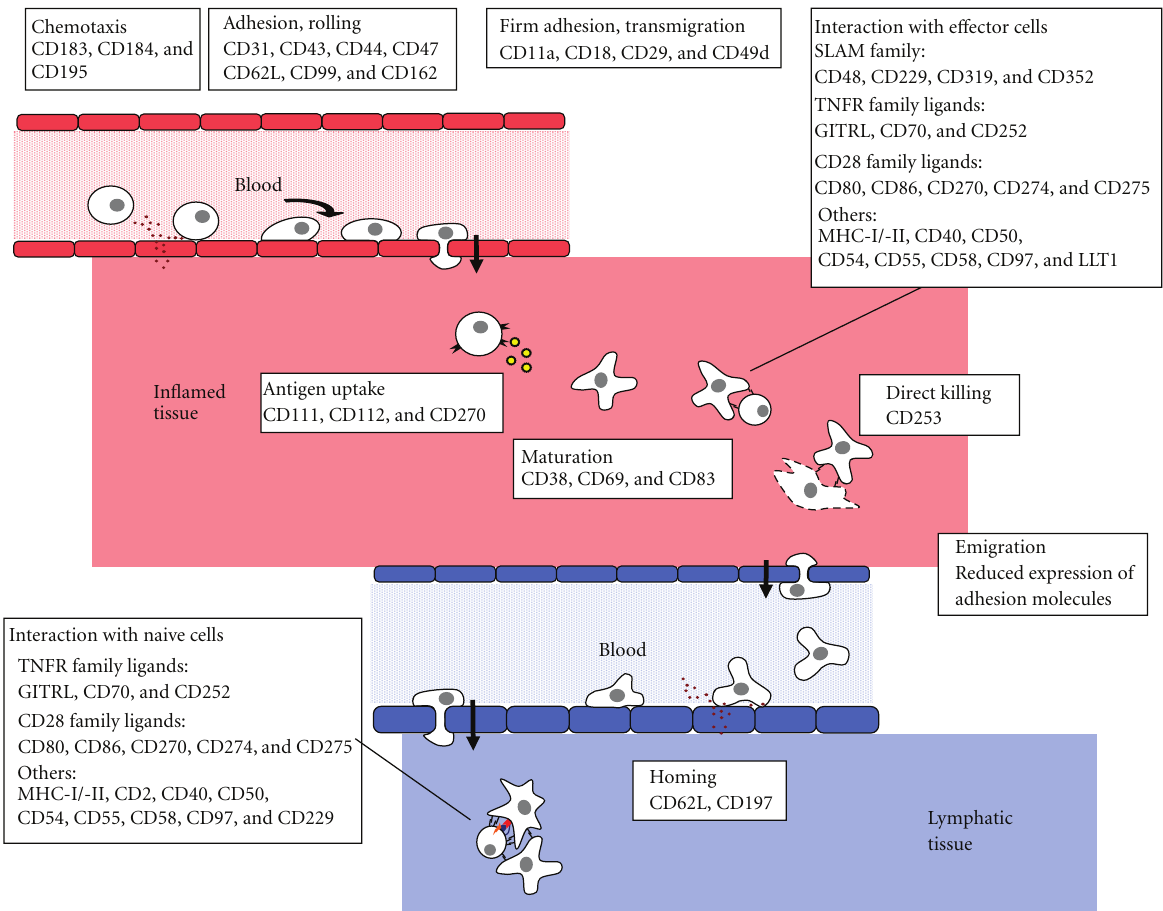
Figure 2: Proposed model for the plasmacytoid dendritic cell (PDC) “life cycle”, which is based on the timely coordinated expression of surface markers after contact with herpes simplex virus (HSV). The upper part of the figure depicts the attraction of PDC to inflamed tissue, where they take up their antigen and interact with local e ff ector cells. Then, PDC reenter the blood stream and home to secondary lymphatic tissue via high endothelial venules (HEV), where they shape the adaptive immune response via interaction with na¨ıve T cells, as outlined at the lower part of the figure.